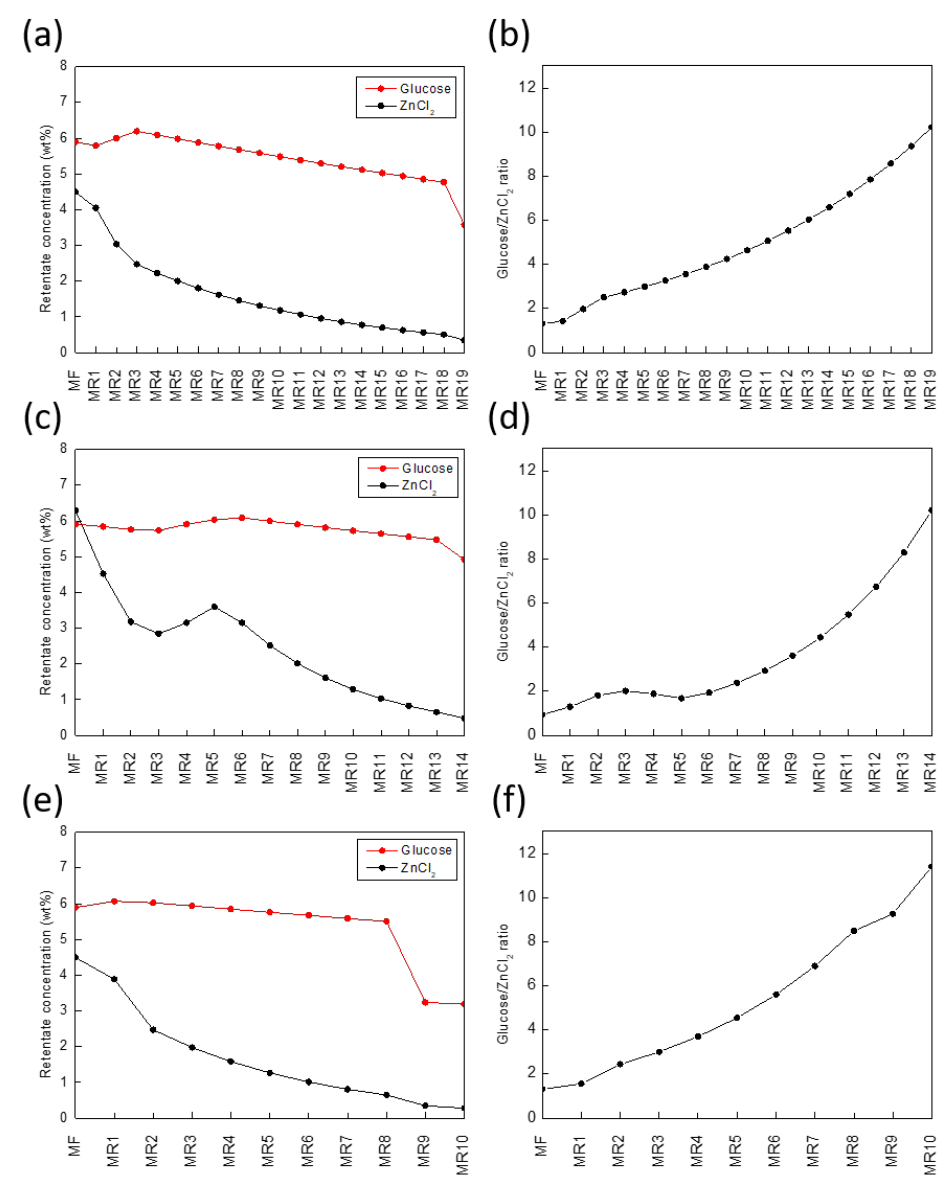
Figure 5. Variations of retentate concentration and the glucose/ZnCl 2 ratio in MF and MR units: ( a ) retentate concentration for scenario 1; ( b ) glucose/ZnCl 2 ratio for scenario 1; ( c ) retentate concentration for scenario 2; ( d ) glucose/ZnCl 2 ratio for scenario 2; ( e ) retentate concentration for scenario 3; ( f ) glucose/ZnCl 2 ratio for scenario 3.